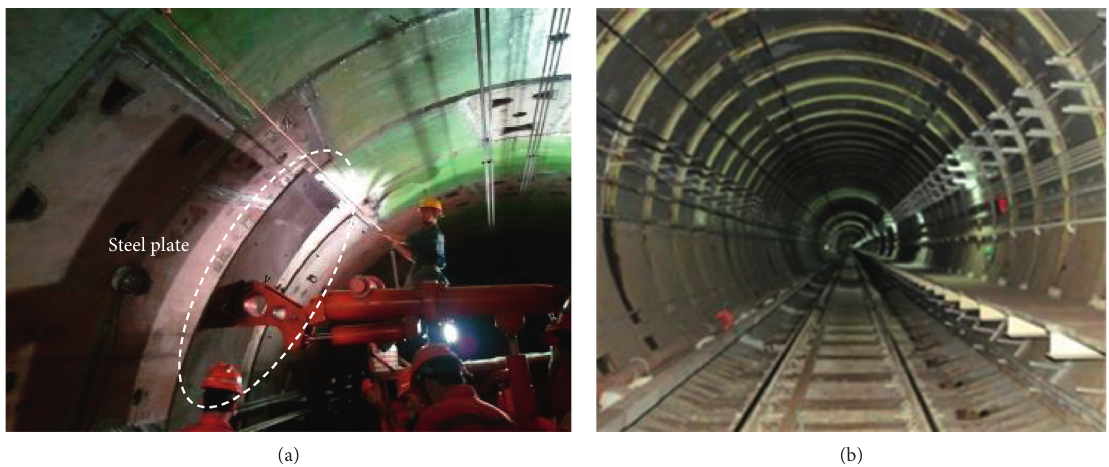
Figure 24: Steel plate strengthening: (a) affixing the steel plate and (b) the overall strengthening